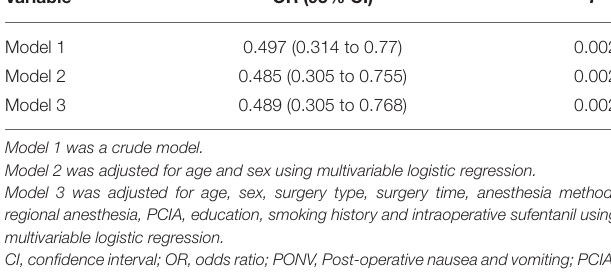
TABLE 4 | Multivariable logistic regression analysis of dexmedetomidine for PONV. Variable